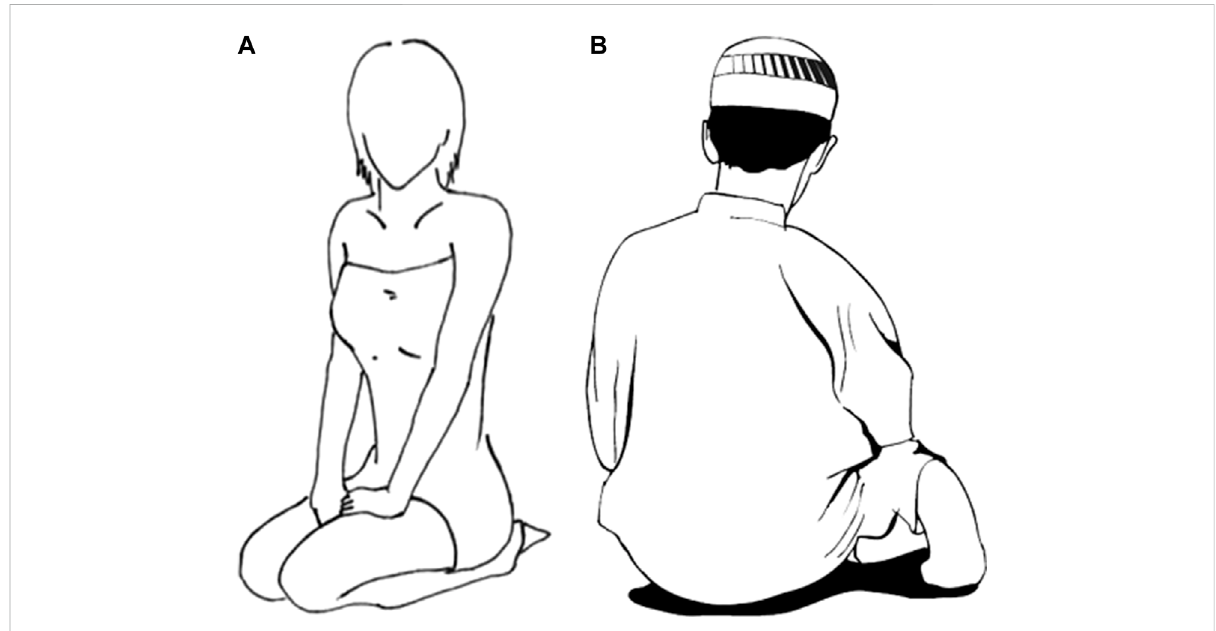
FIGURE 2 Sitting positions that require large fl exion angles (A) Seiza (Ohno et al., 2016), (B) Tasyahud (Magee,